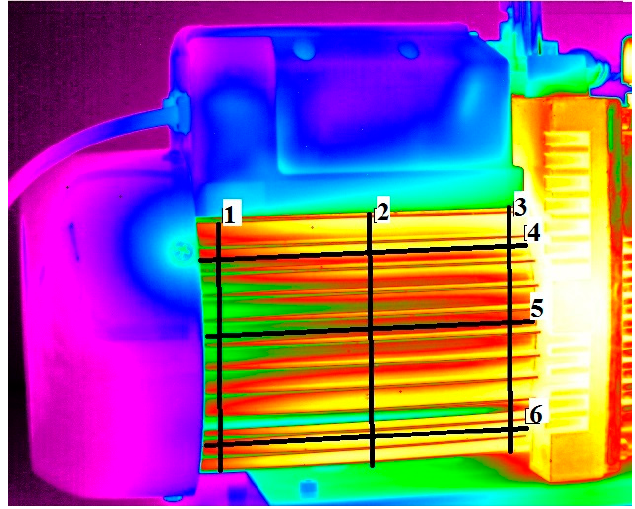
Figure 4. Thermogram of the housing. (Lines: 1 to 6 shows the location of points from which measured temperature values were taken to generate the diagram of temperature distribution shown in Figure 5 and Figure 6.